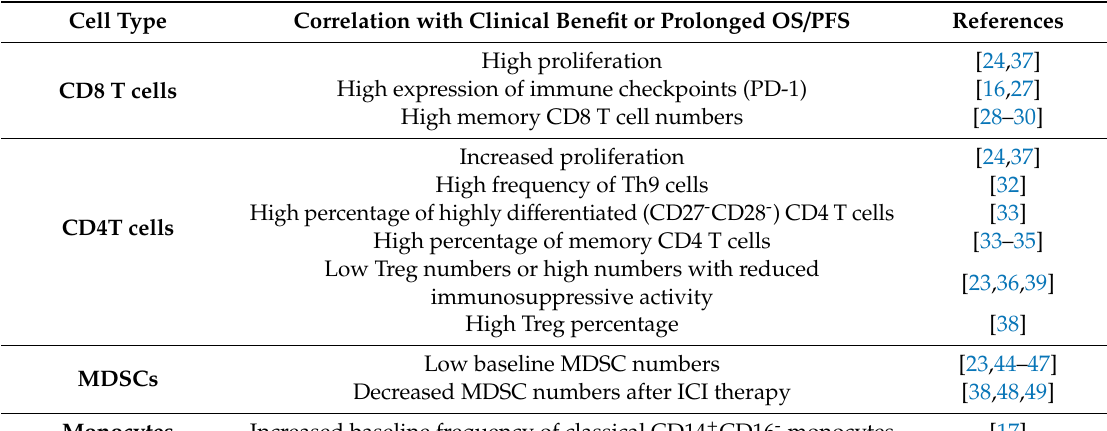
Table 1. Levels of specific peripheral immune cells correlated with clinical outcome of cancer patients under ICI therapy.